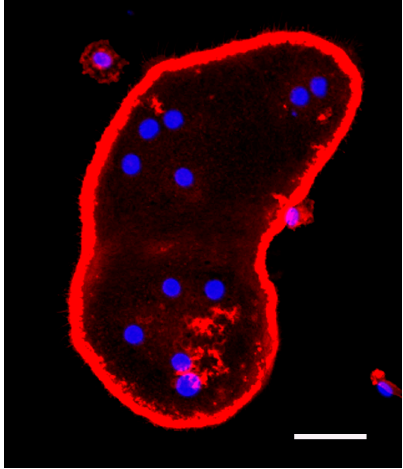
Figure 4. Microscopic image of a cultured osteoclast. Murine bone marrow macrophages were incubated for 82 h with RANKL (100 ng/mL) and M-CSF (10 ng/mL), resulting in osteoclast formation. After culturing, cells were fixed with 4% paraformaldehyde in phosphate buffer and stained with DAPI and Rhodamine B-conjugated phalloidin. Osteoclasts are multinucleated giant cells with a ring-shaped osteoclast-specific podosome belt termed the actin ring. Blue, nuclei; red, actin; scale bar = 50 µm.